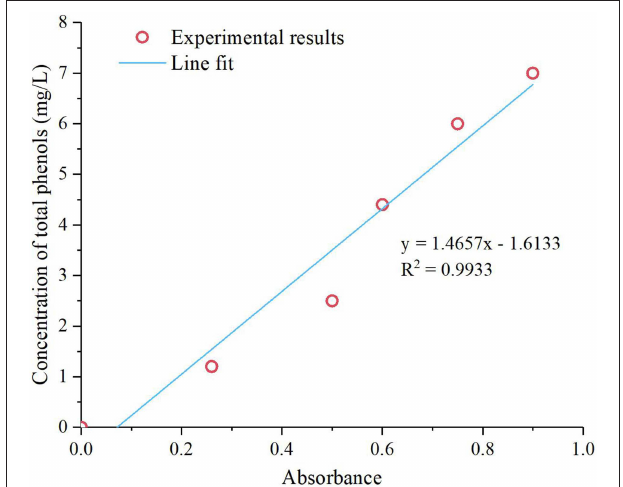
FIGURE 2 | Curve of garlic acid standard.